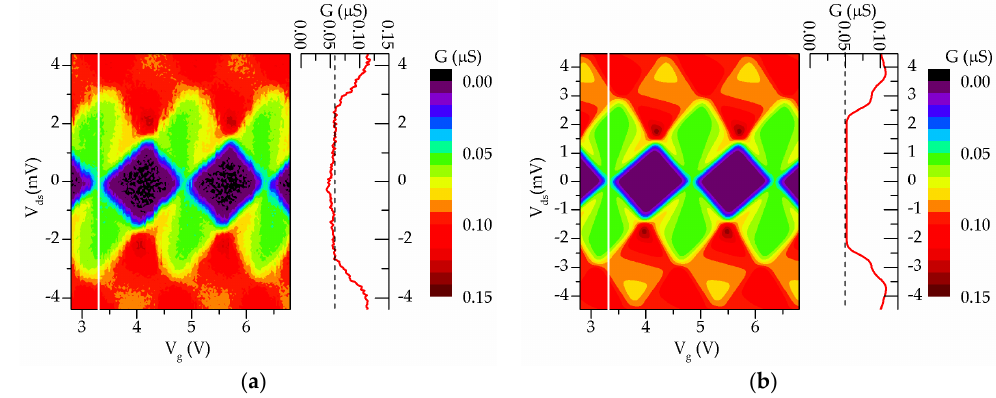
Figure 15. ( a ) Coulomb diamonds of a Ni ‐ SiO 2 ‐ Ni device treated with FGA+RHP along with a G ( V ds ) cross section at V g = 3.3 V; and ( b ) simulations of an MIM SET along with a G ( V ds ) cross section at V g = 3.3 V using the following parameters: C g = 0.106 aF, C d = 47 aF, C s = 63 aF, G d = 0.35 μ S, G s = 0.50 μ S, T = 0.5 K.